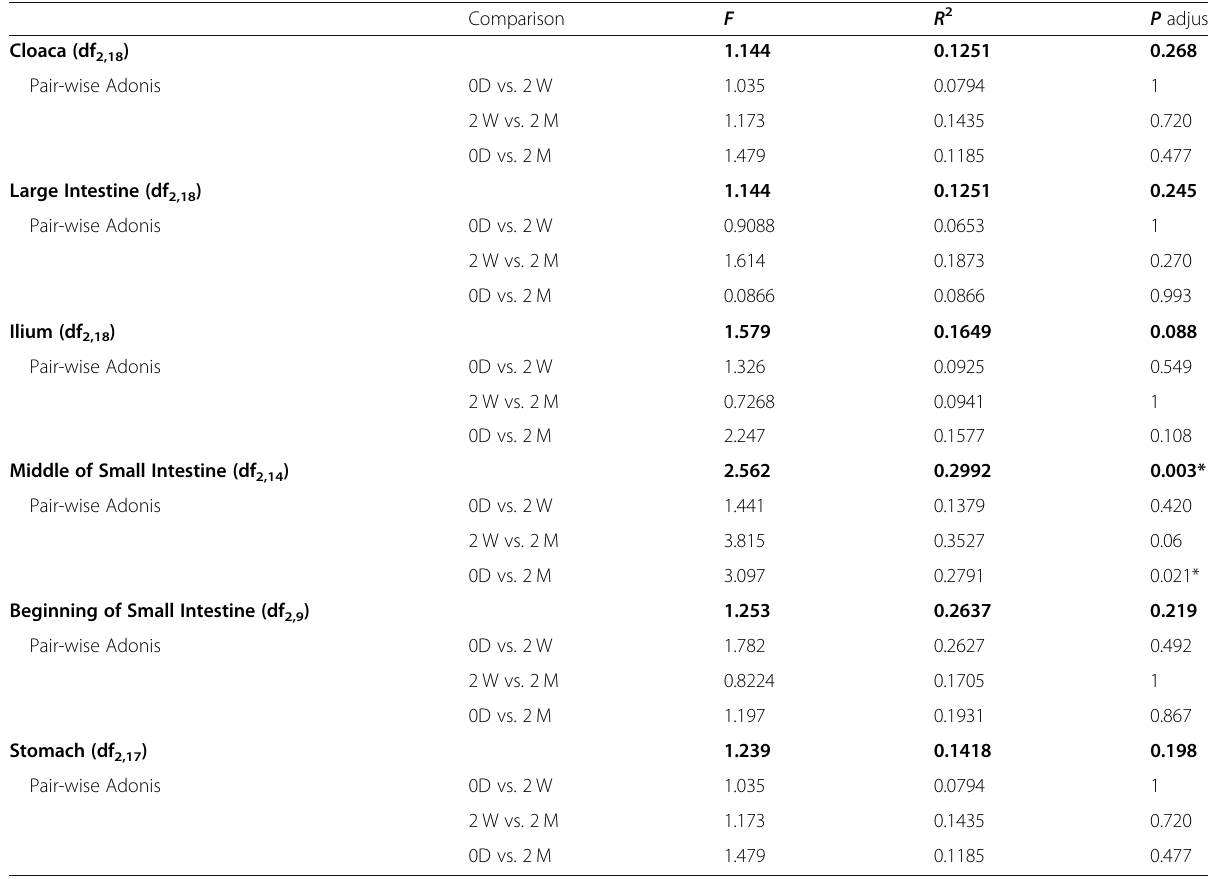
Table 2 Results of Adonis (bold) and pairwiseAdonis (Bray-Curtis distances) analyses of gut microbial communities of digestive tract regions of fresh (0D), two-weeks old (2 W), and two-months (2 M) old alcohol